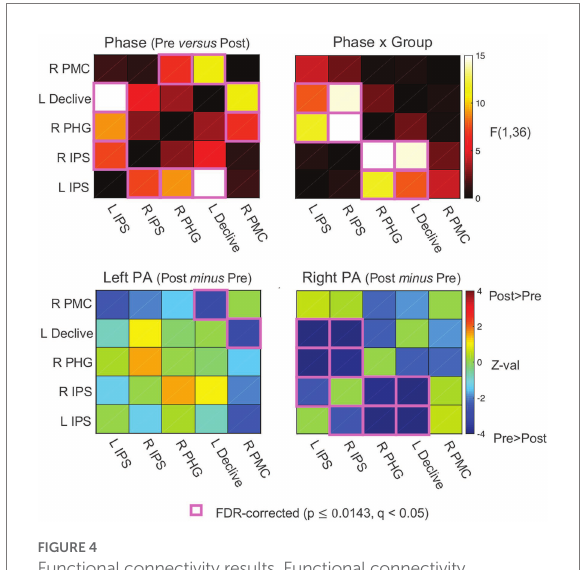
FIGURE 4 Functional connectivity results. Functional connectivity correlation matrices. PA, prism adaptation. Pre, before PA; Post, after PA; IPS, intraparietal sulcus; PHG, parahippocampal gyrus; PMC, premotor cortex. See also Supplementary